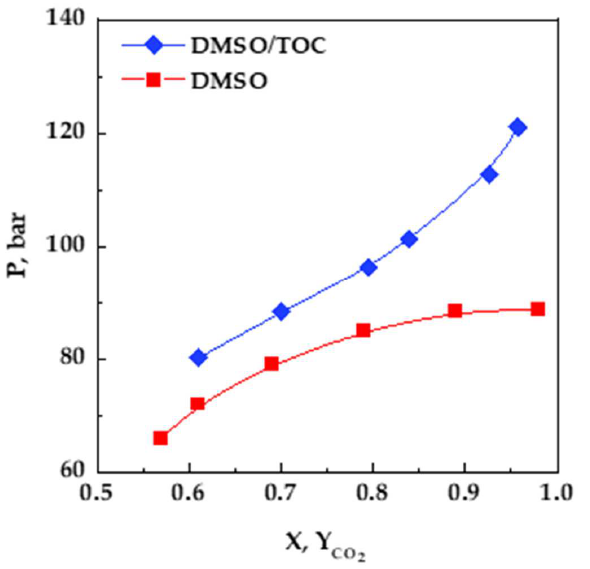
Figure 4. Comparison in a P-x diagram between DMSO/CO 2 /TOC system and pure DMSO at a temperature of 313 K.